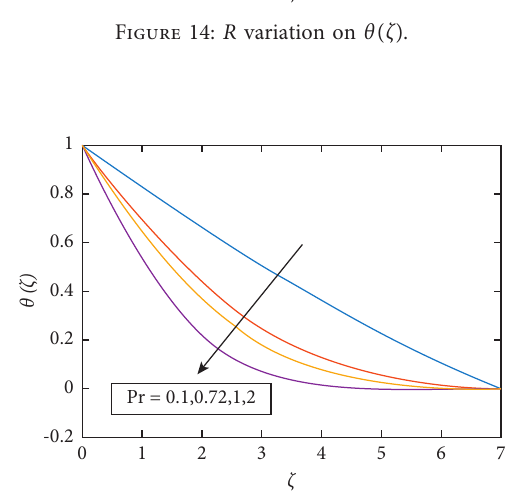
Figure 12: c variation on f ′ ( ζ ) .